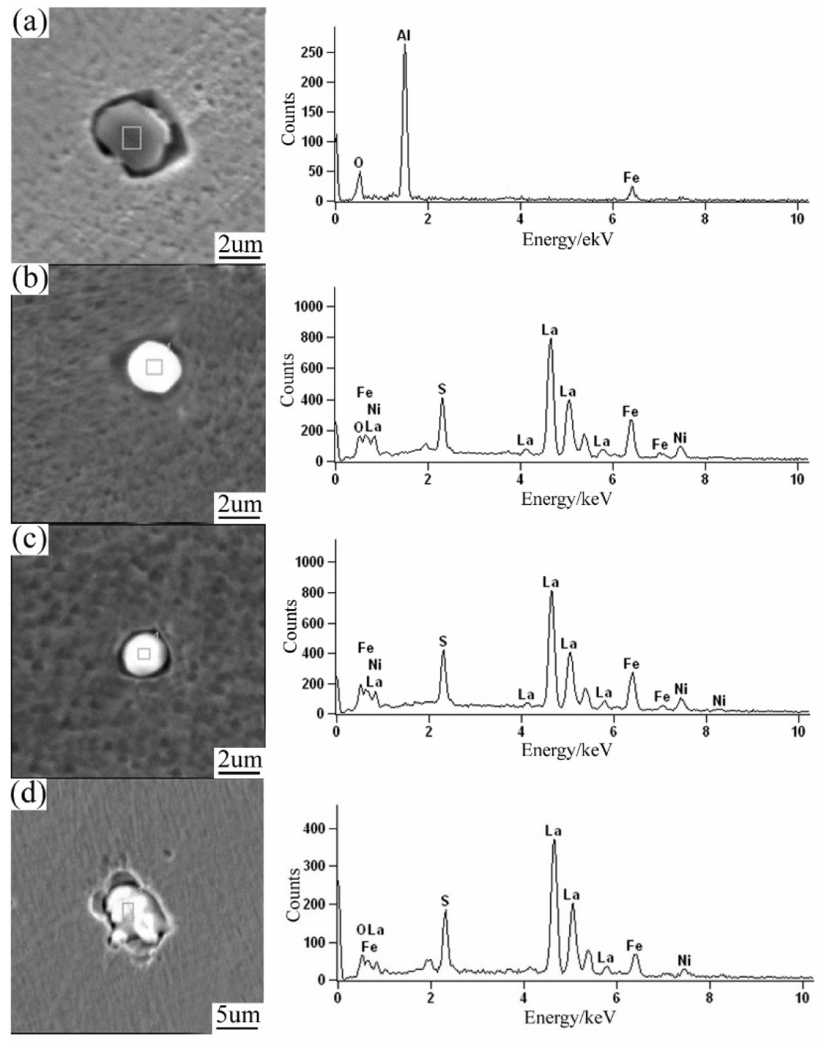
Figure 7: Morphology and energy spectrum analysis of typical inclusions in tested alloys.